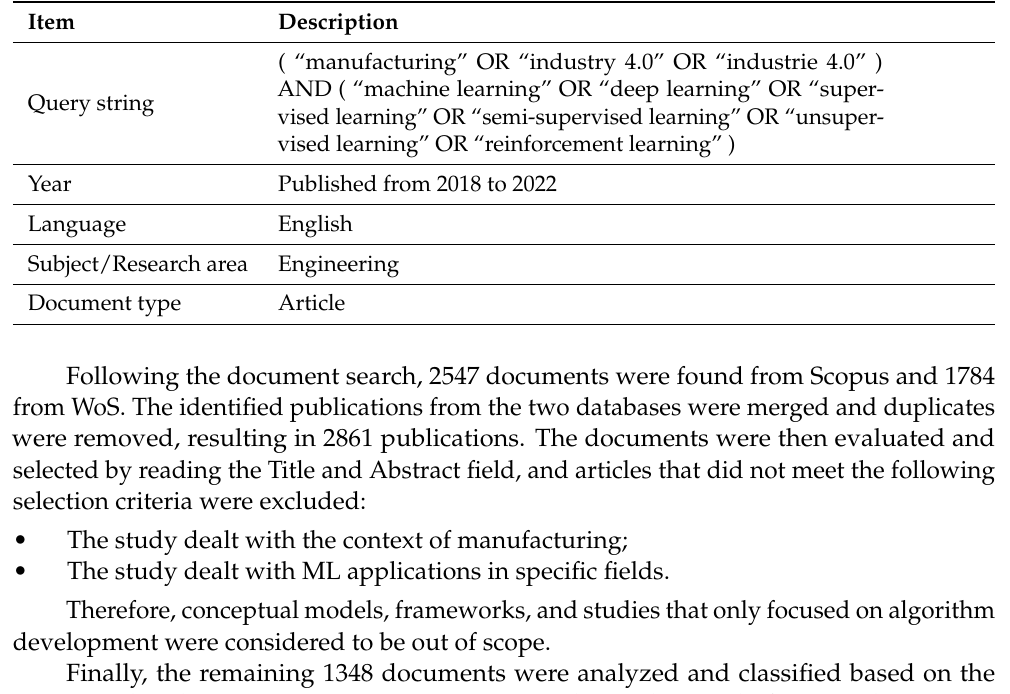
Table 2. Limitations for document